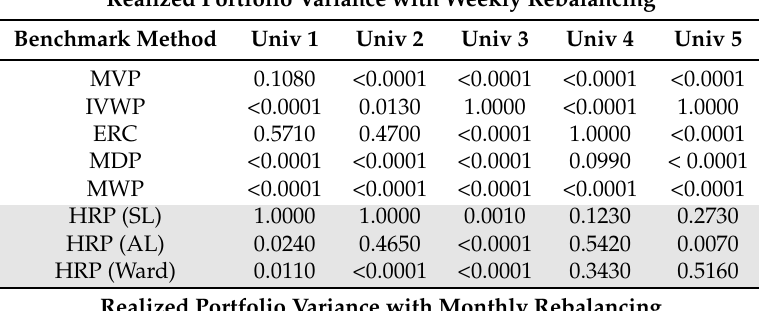
Table A2. p c -value of different benchmark portfolios based on the out-of-sample portfolio variance for different rebalancing horizons. The covariance forecast model is taken as DCC-GARCH.